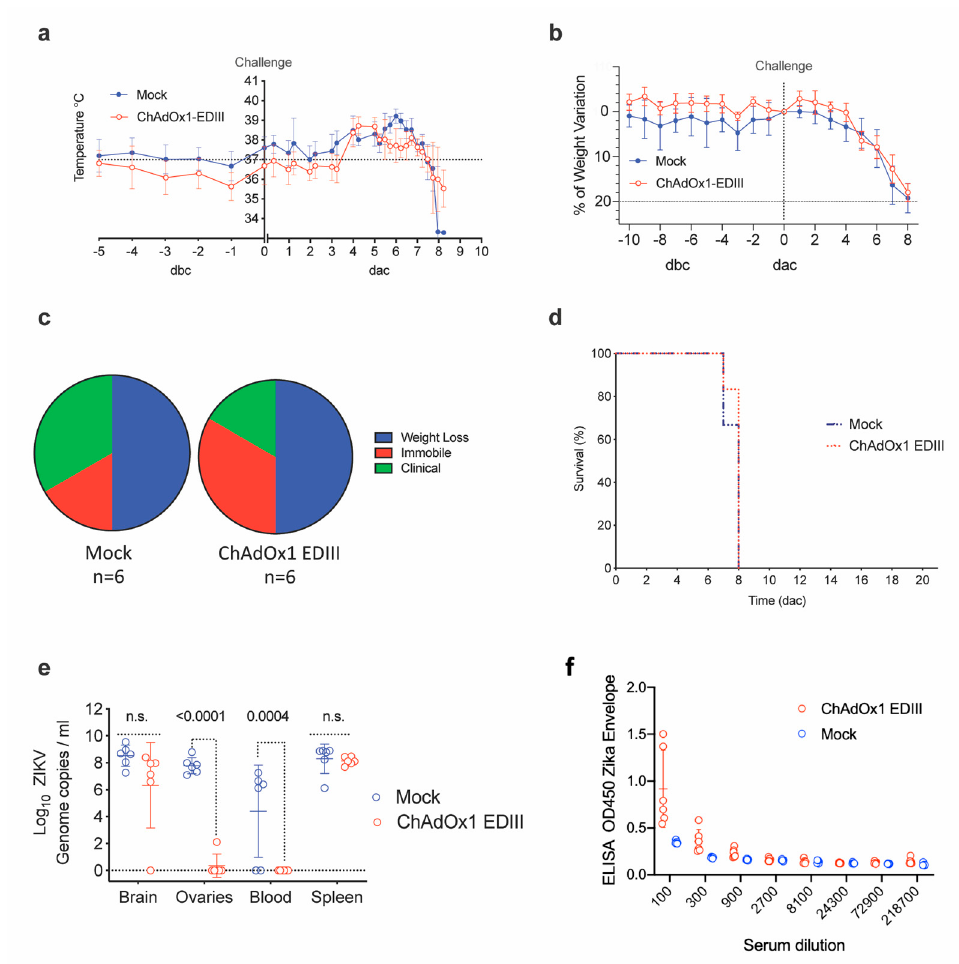
Figure 5. Efficacy parameters after a ZIKV challenge in vaccinated A129. ( a ) Variation in temperatures from 5 days before challenge (dbc) and 10 days post-ZIKV challenge (dac). Lines represent the mean of control (unrelated or mock-control, blue line) and vaccinated groups (red line), ( n = 6). ( b ) Differences in weight compared to the day of challenge in the control and vaccinated groups. Mouse weight was monitored from day-5 before challenge and up to the date animals were culled, and up to 8 days after challenge. ( c ) Pie charts in percentage that represents the clinical manifestation of the disease (ruffled fur, lethargy, pinched, hunched, wasp-waisted, labored breathing, decrease of mobility and body weight loss), in control and vaccinated groups. ( d ) Kaplan-Meier survival curves with lines representing each vaccinated or control group ( n = 6). ( e ) ZIKV RNA in mice upon completion of the experiment, day of culling end of the study (21 days after challenge, dac), by RT-PCR. Each dot indicates a mouse from vaccinated or control groups and for each of the brain, ovaries, blood, and spleen tissue. Boxes indicate the mean value and the lines the standard deviation. ( f ) Anti-ZIKV Envelope responses induced by vaccination and measured before challenge.